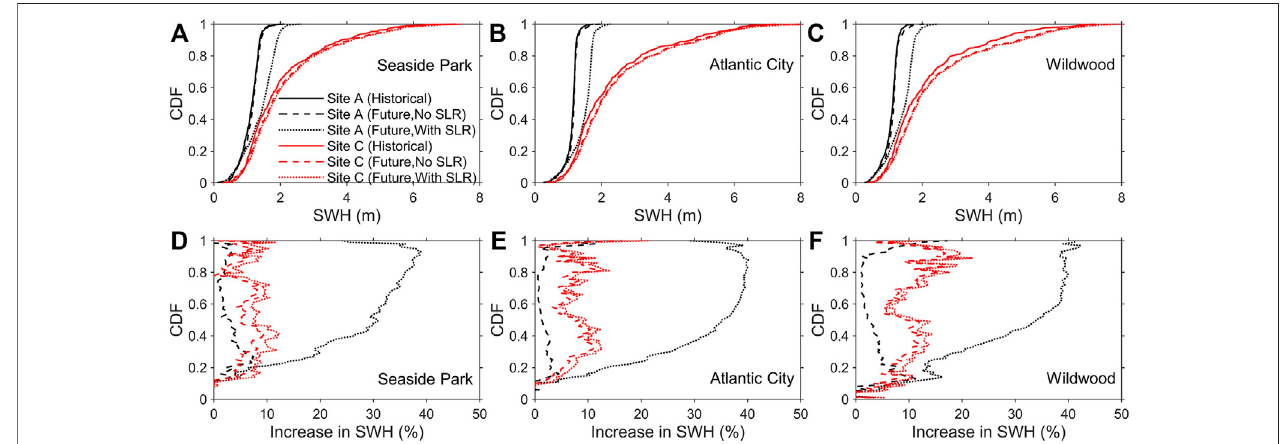
FIGURE 10 | Percent increase in the CDF of historical and future SWH at the selected sites.